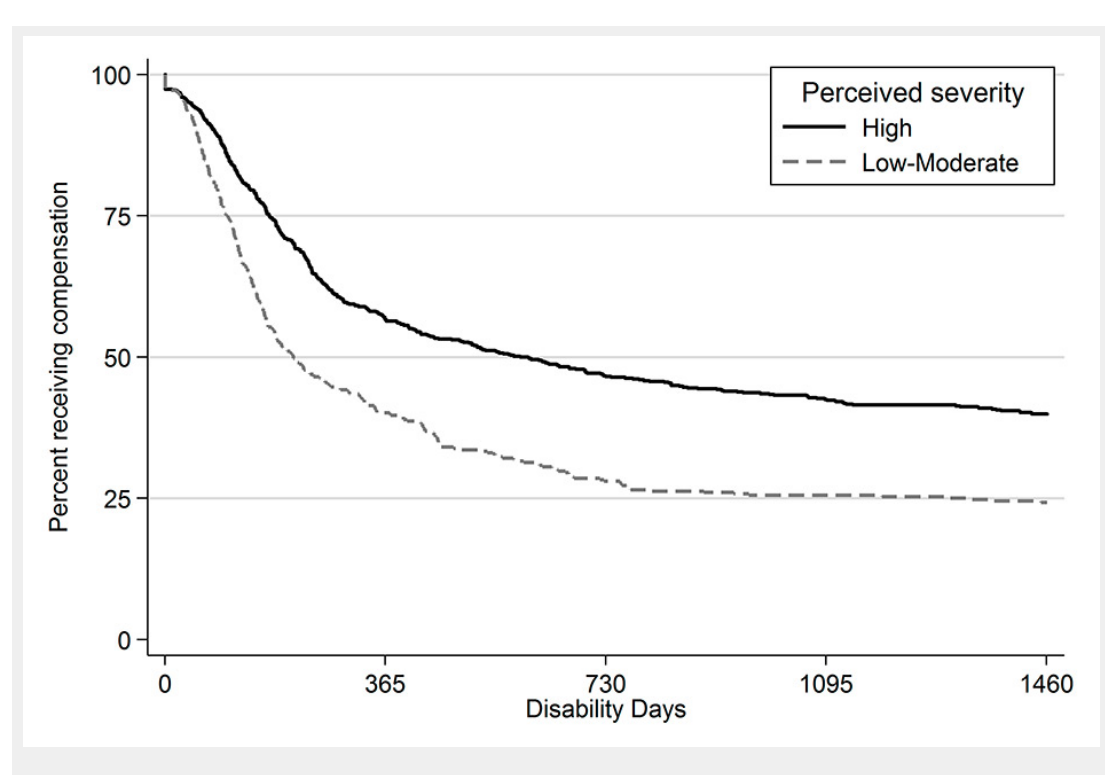
Figure 3 Survival functions according to the perceived severity of the